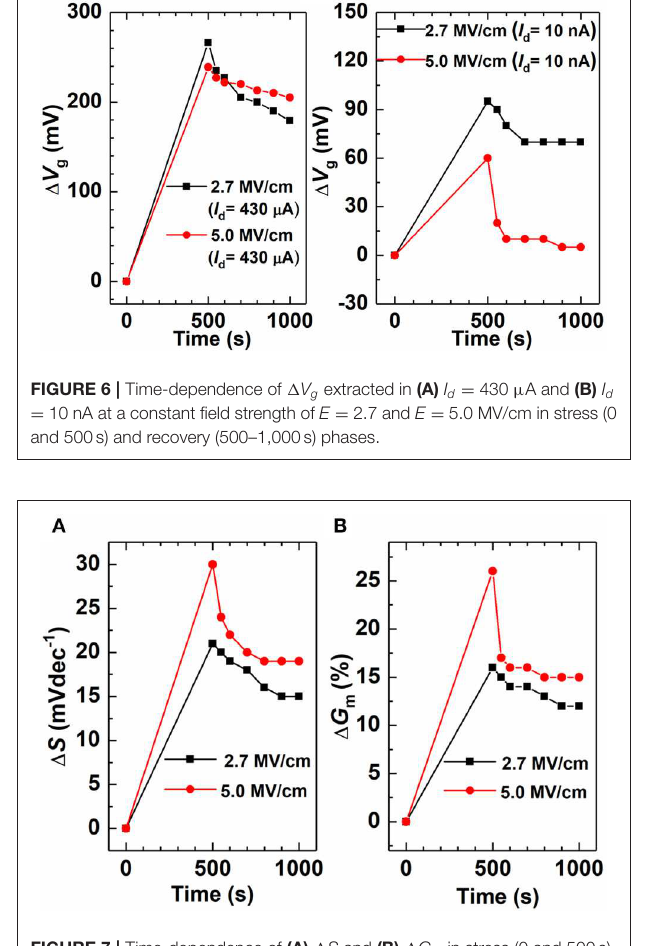
of negatively charged permanent acceptor traps, and 1 N DR